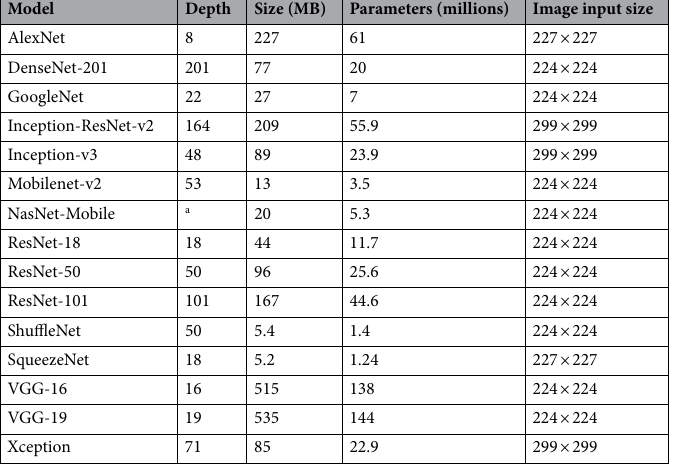
Table 1. Pre-trained deep learning models using ImageNet. a The NasNet-Mobile does not consist of a linear sequence of modules. MB,